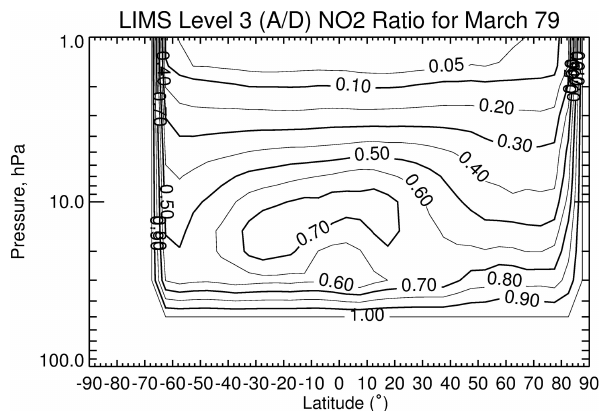
Figure 14. LIMS V6 monthly zonal mean daytime ozone (solid) for April 1979 at 38 ◦ N compared with an average of three soundings (*) at Wallops Island, VA, 38 ◦ N, in April of 1976–1978. Horizontal bars are error estimates for LIMS (solid) and for a ROCOZ sound- ing